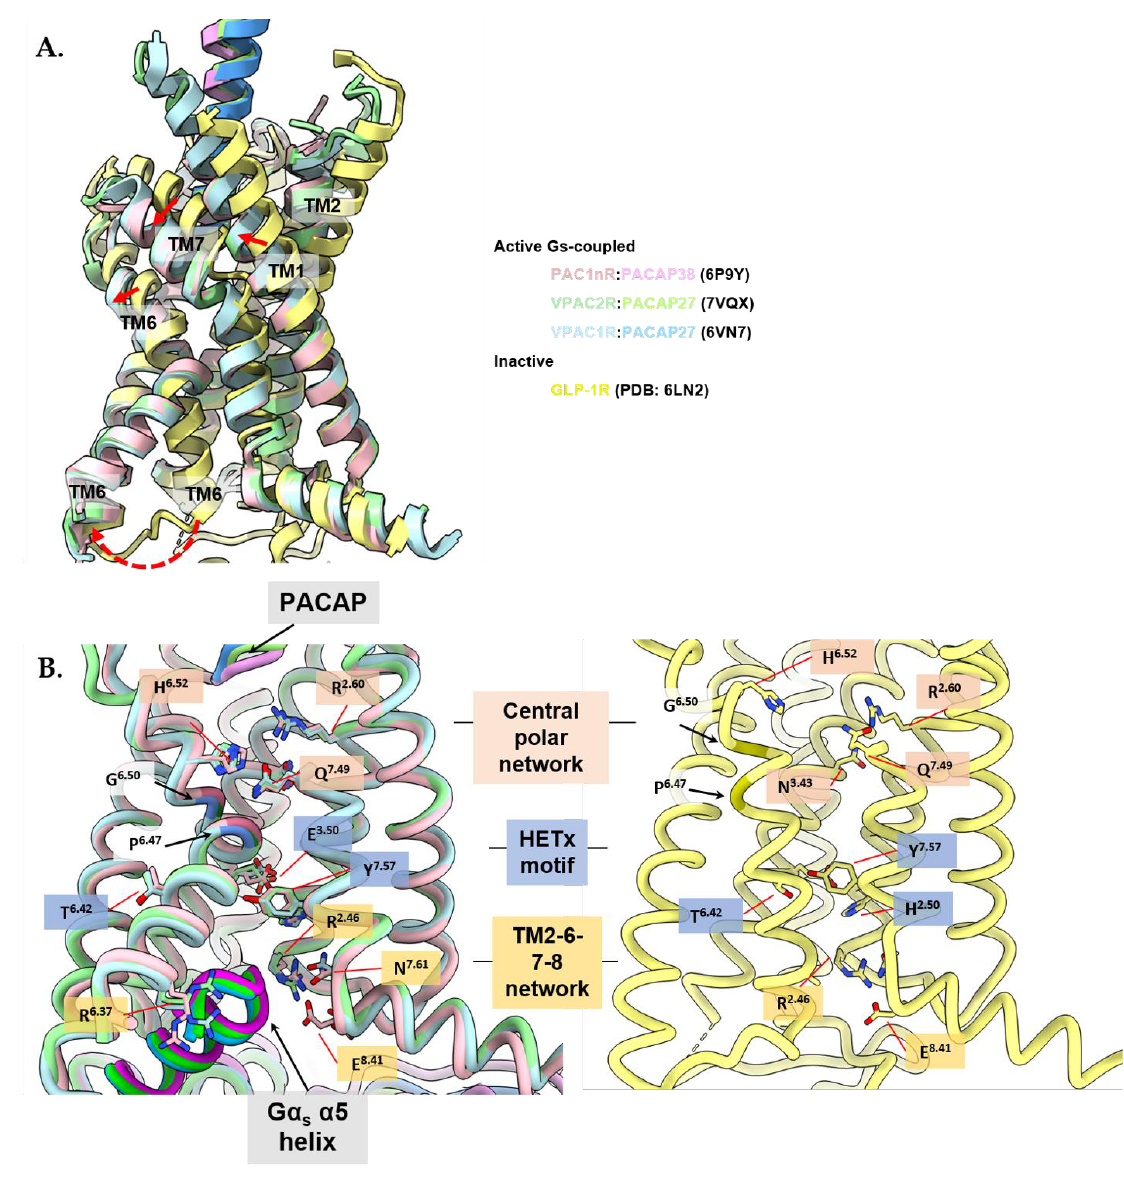
Figure 6. The active receptor conformation is similar between members of the PACAP subfamily of receptors. Active, G s -coupled PACAP-bound receptors are displayed: VPAC1R (blue; PDB: 6VN7), VPAC2R (green; PDB: 7VQX), and PAC1nR (pink; PDB: 6P9Y) and compared to the inactive crystal structure of full length human GLP1 receptor (GLP1-R) in complex with Fab fragment (Fab7F38) (yellow; PDB: 6LN2). Structures were aligned by receptor chains and displayed as ribbons as side views, with important residues shown as sticks using ChimeraX 1.3 [310,311]. G α s- α 5 helix colored in darker colors corresponding to the respective receptor chains ( B , left panel). The Fab fragment in inactive GLP1-R was omitted for clarity. ( A ) Comparison between active structures of the PACAP subfamily of receptors and the full-length inactive structure of GLP1-R indicate inward movement of TM1 and outward movement of TM6 and 7 upon receptor activation with TM6 undergoing a kink at the Pro 6.47 xxGly 6.50 motif. Movement of TMs indicated by red arrows. The G protein was omitted for clarity. ( B ) Comparison between conserved residues in the central polar network (pink shading-top), HETx motif (blue shading-middle) and TM2-6-7-8 network (yellow shading-bottom) between the active PACAP subfamily of receptor structures (left panel) and the inactive GLP1-R structure (right panel) indicate rearrangement of the conserved polar networks for TM6 to kink at the Pro 6.47 xxGly 6.50 motif and accommodate the α 5 helix of G α s at the cytoplasmic